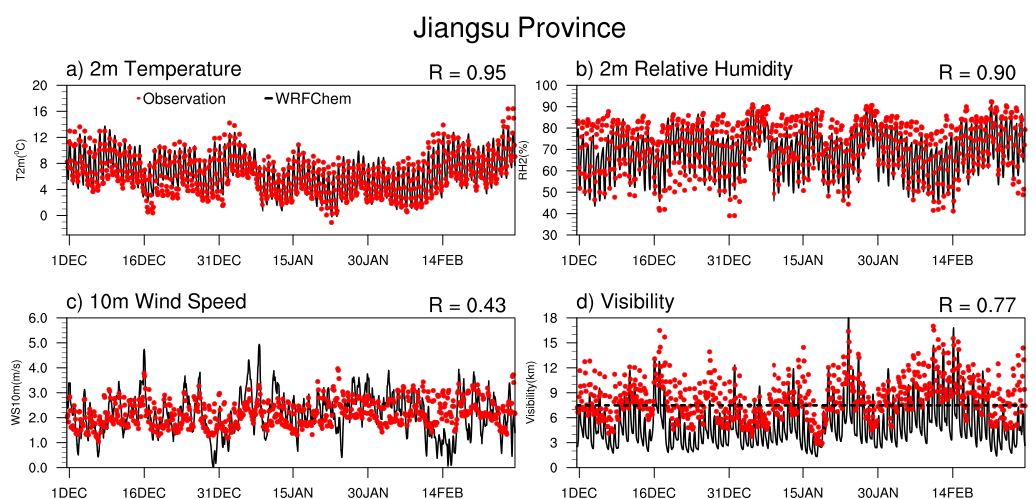
Figure 5. The temporal variation of multi-winter (2013–2017) mean 3-hourly ( a ) 2m temperature, ( b ) 2m relative humidity, ( c ) 10m wind speed, ( d ) visibility in Jiangsu province in observation (red spots) and WRF-Chem simulation (black curves).